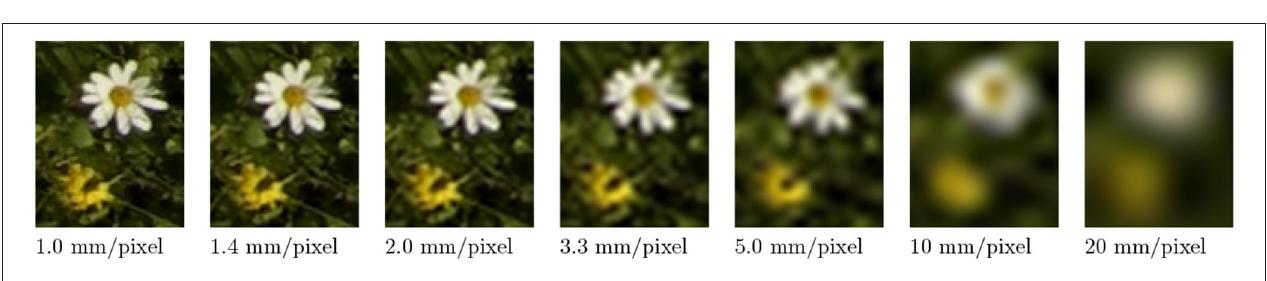
FIGURE 7 | Ground sampling distance degradation on an excerpt of an aerial